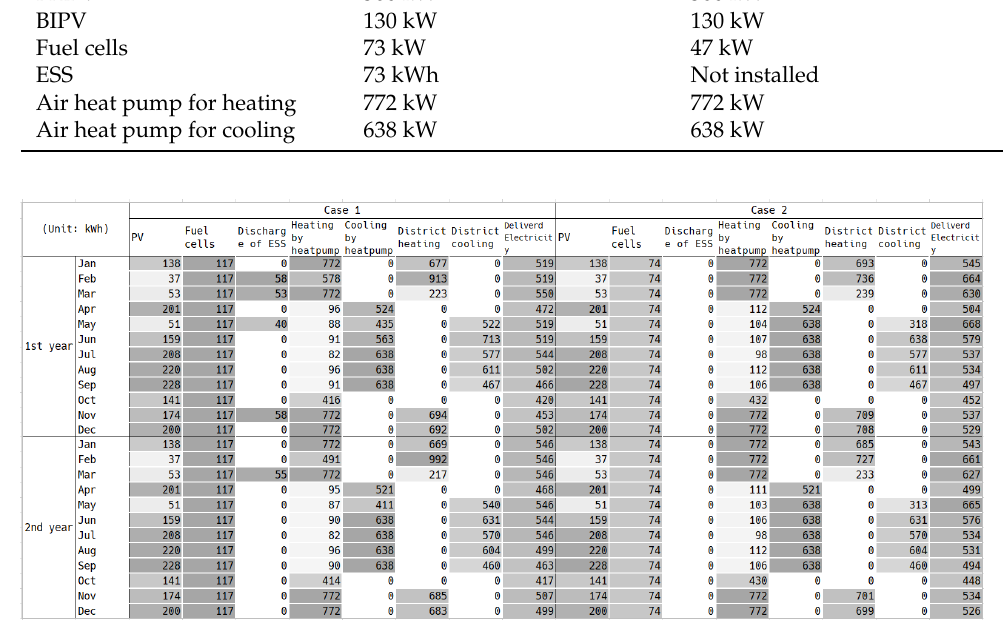
Figure 5. The energy operation results at the time of peak monthly demand in Case 1 and Case